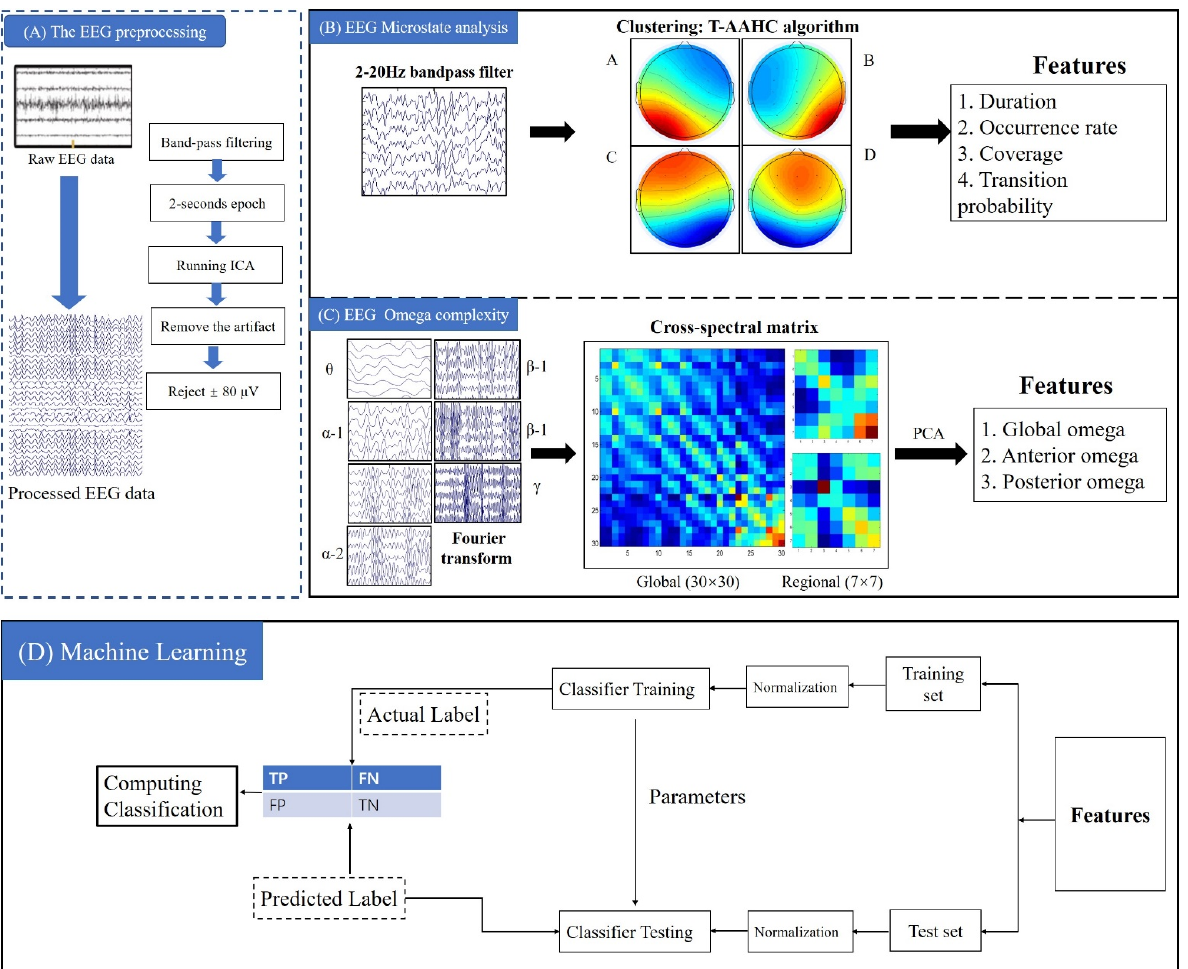
Figure 1. Analysis procedures for resting ‐ state data sets. ( a ) Resting ‐ state data pre ‐ processing; ( b ) microstates analysis; ( c ) omega complexity analysis; ( d ) subclinical depression prediction.